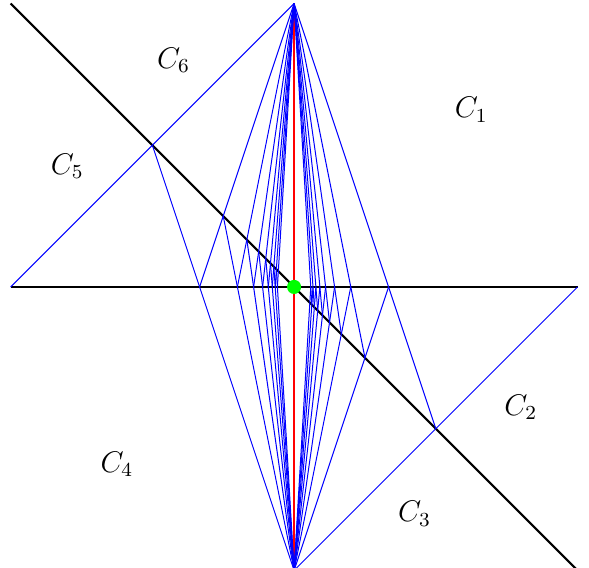
Figure 7. A schematic representation of the cone structure near the limiting ray of A 2 , 1 , a rank 3 cluster algebra. The full scattering diagram is 3 dimensional and we are looking down on the limiting ray, which is indicated by the green dot. The red line corresponds to the limiting wall. The black lines correspond to cluster walls that intersect the limiting ray. The blue lines correspond to asymptotic walls, cluster walls that do not intersect the limiting wall and become more parallel with a limiting wall as one approaches the limiting ray. There are 6 asymptotic chambers, each labeled by C i